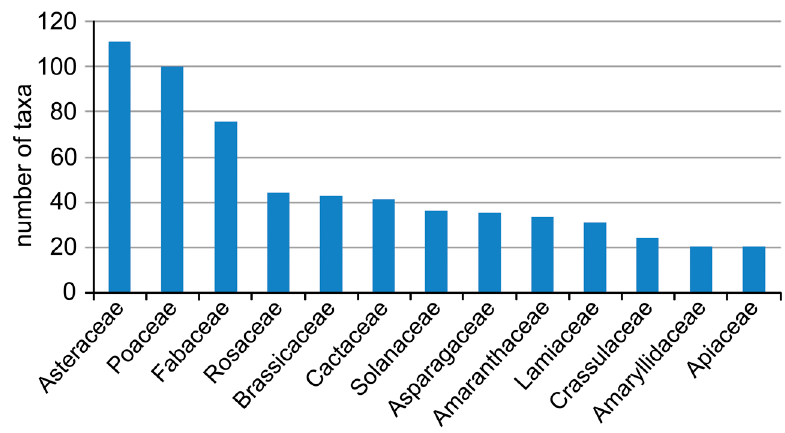
Figure 3. Families with the highest diversity of alien taxa in the Catalan flora.